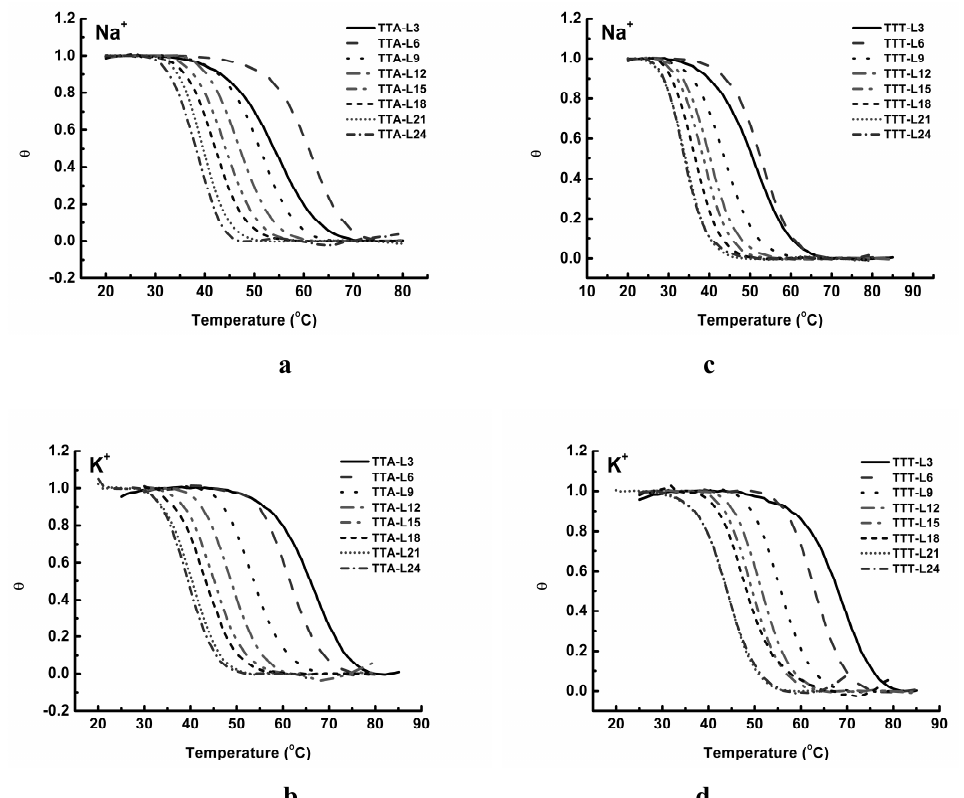
Figure 5. Folded fraction curves derived from UV melting curves of TTA series and TTT series. ( a ) TTA series in 100 mM Na + solution; ( b ) TTA series in 100 mM K + solution; ( c ) TTT series in 100 mM Na + solution; ( d ) TTT series in 100 mM K + solution. Table 1. Thermal dynamic parameters ( ∆ H , T ∆ S and ∆ G (25 ◦ C)) of TTA sequences in 100 mM NaCl or 100 mM KCl solutions, respectively.